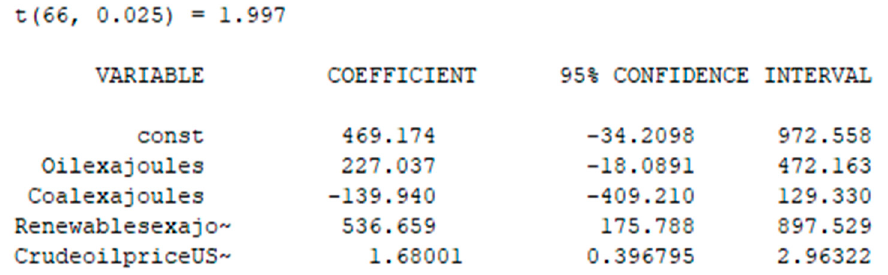
Figure 8. Testing on adequacy for the Fixed Effects model.